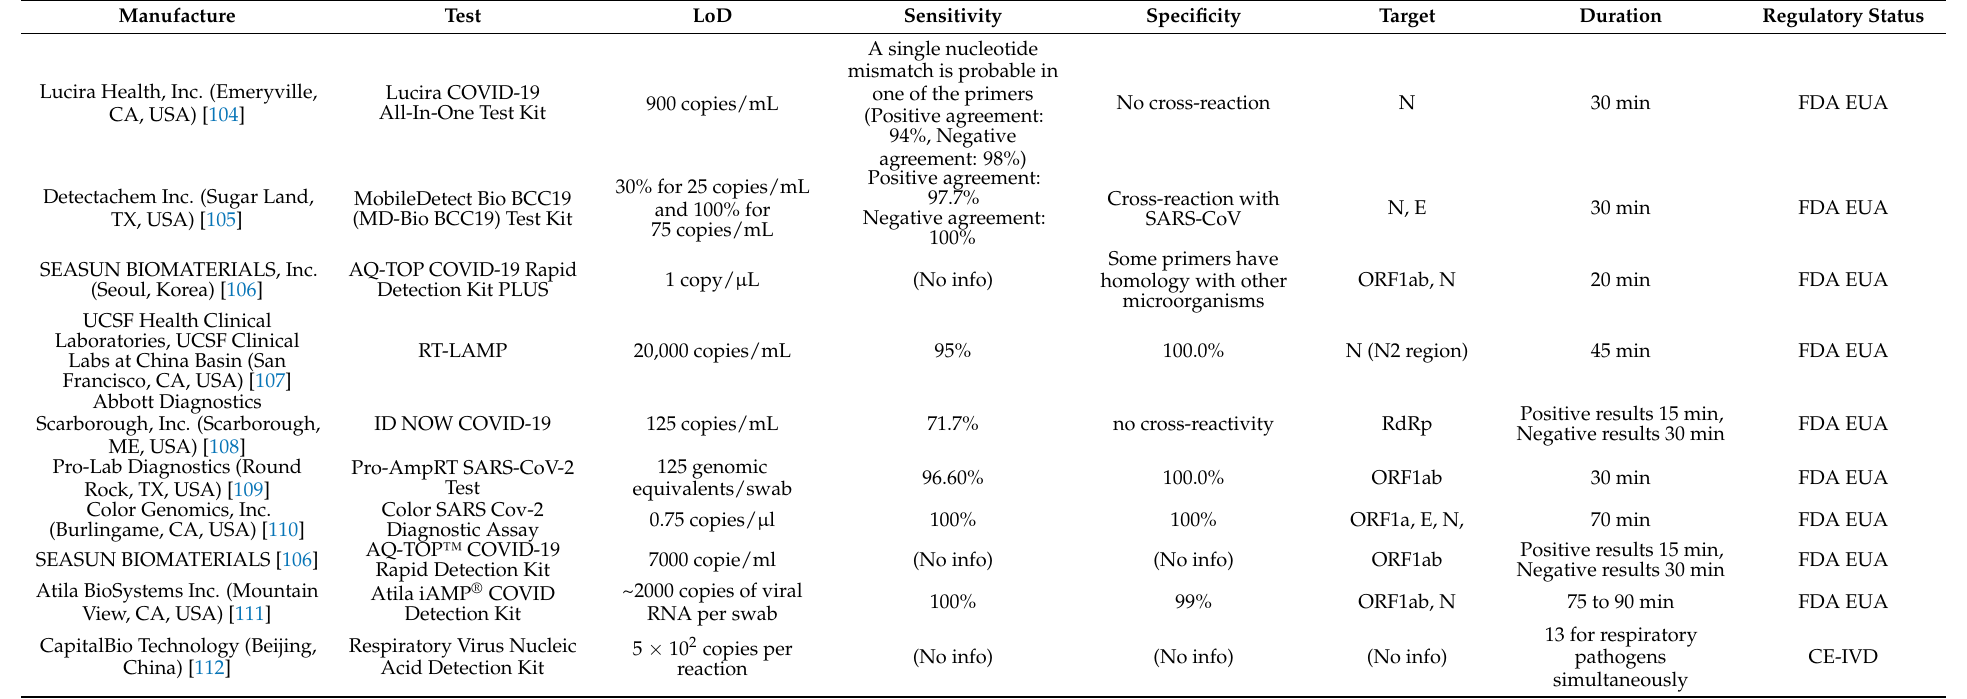
Table 2. A selected list of the developed LAMP-based tests and their performance for COVID-19